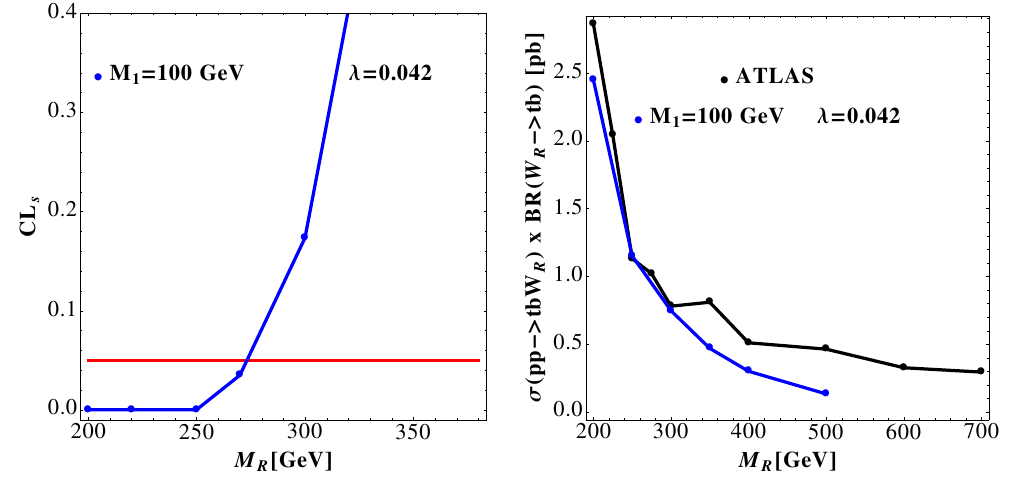
Figure 2 . Left: CL s exclusion limits on M R obtained by recasting the CMS multilepton search in ref. [49] using the G category. Masses for which CL 0 . 05 are excluded at 95% C.L. Right: s < 95% C.L. exclusion limits of M , obtained by recasting the ATLAS search for heavy charged R